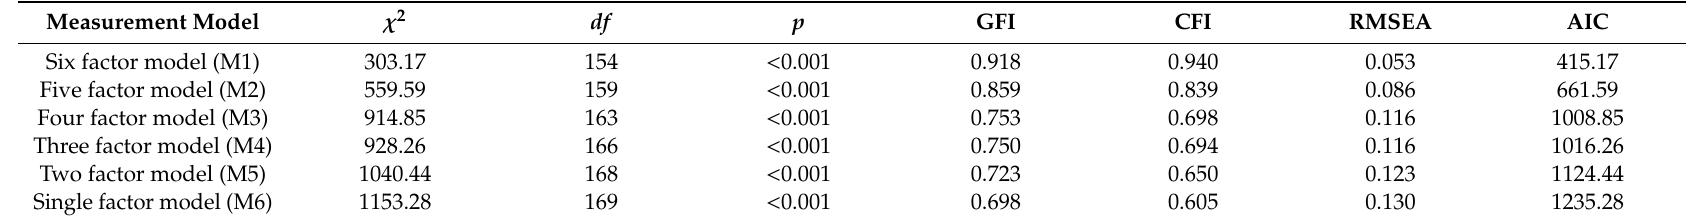
Table 2. Model Fit Summary and Measurement Models